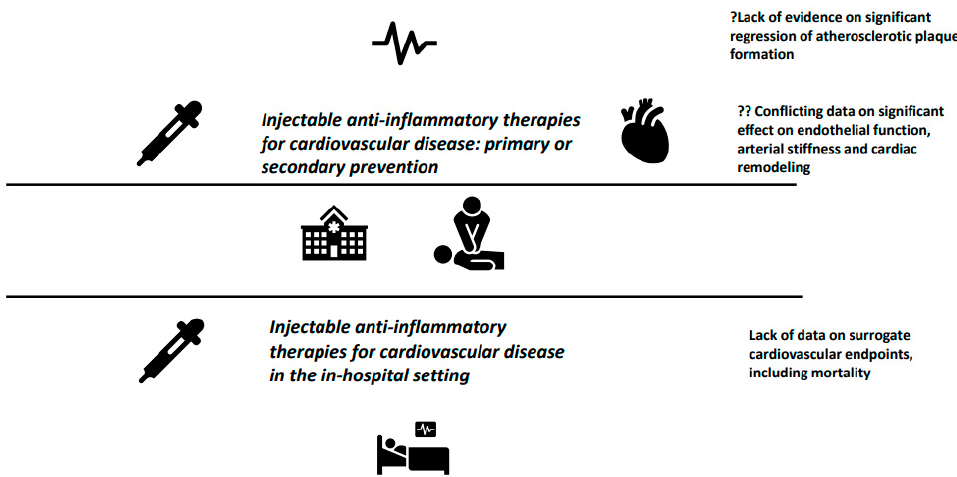
Figure 2. Injectable IL-1 and IL-6 antagonists for the primary and secondary prevention of major forms of CVD, as well as treatment of CVD in the in-hospital setting: conflicting pathophysiologic data and lack of high-quality clinical trials.